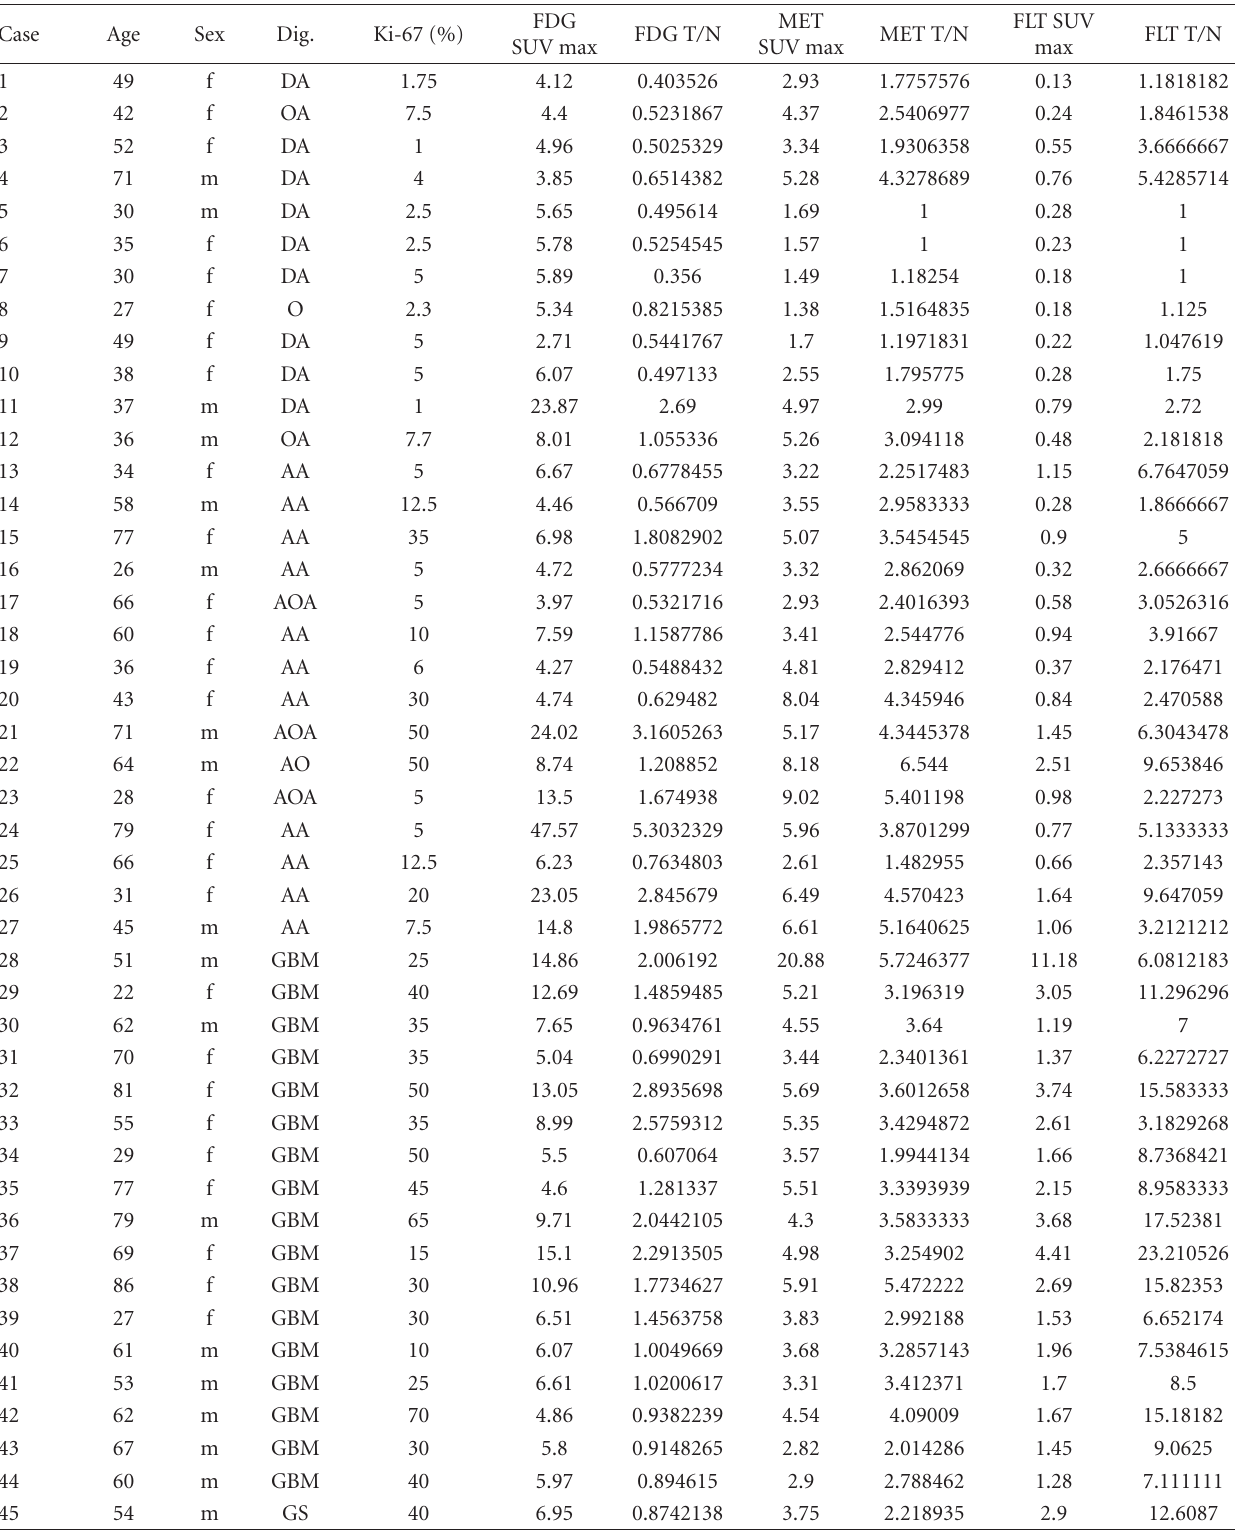
Table 1: Patient characteristics and semiquantitative PET results for FDG, MET, and FLT. Dig: histological diagnosis, DA: di ff use astrocytoma, OA: oligoastrocytoma, O: oligodendroglioma, AA: anaplastic astrocytoma, AOA: anaplastic oligoastrocytoma, AO: anaplastic oligodendroglioma, GBM: glioblastoma multiforme, GS: gliosarcoma, SUV max maximum standardized uptake value, T/N ratio tumor-to- normal tissue count